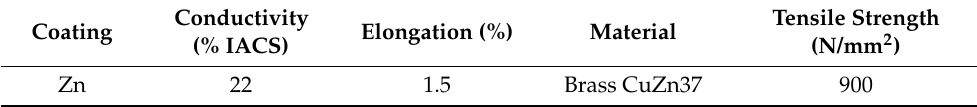
Table 1. Properties of the wire electrode used in the WEDM process. Coating